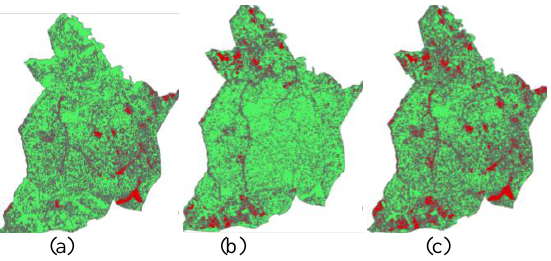
Figure 12 – Normalized LC, SC, and TV vegetation per